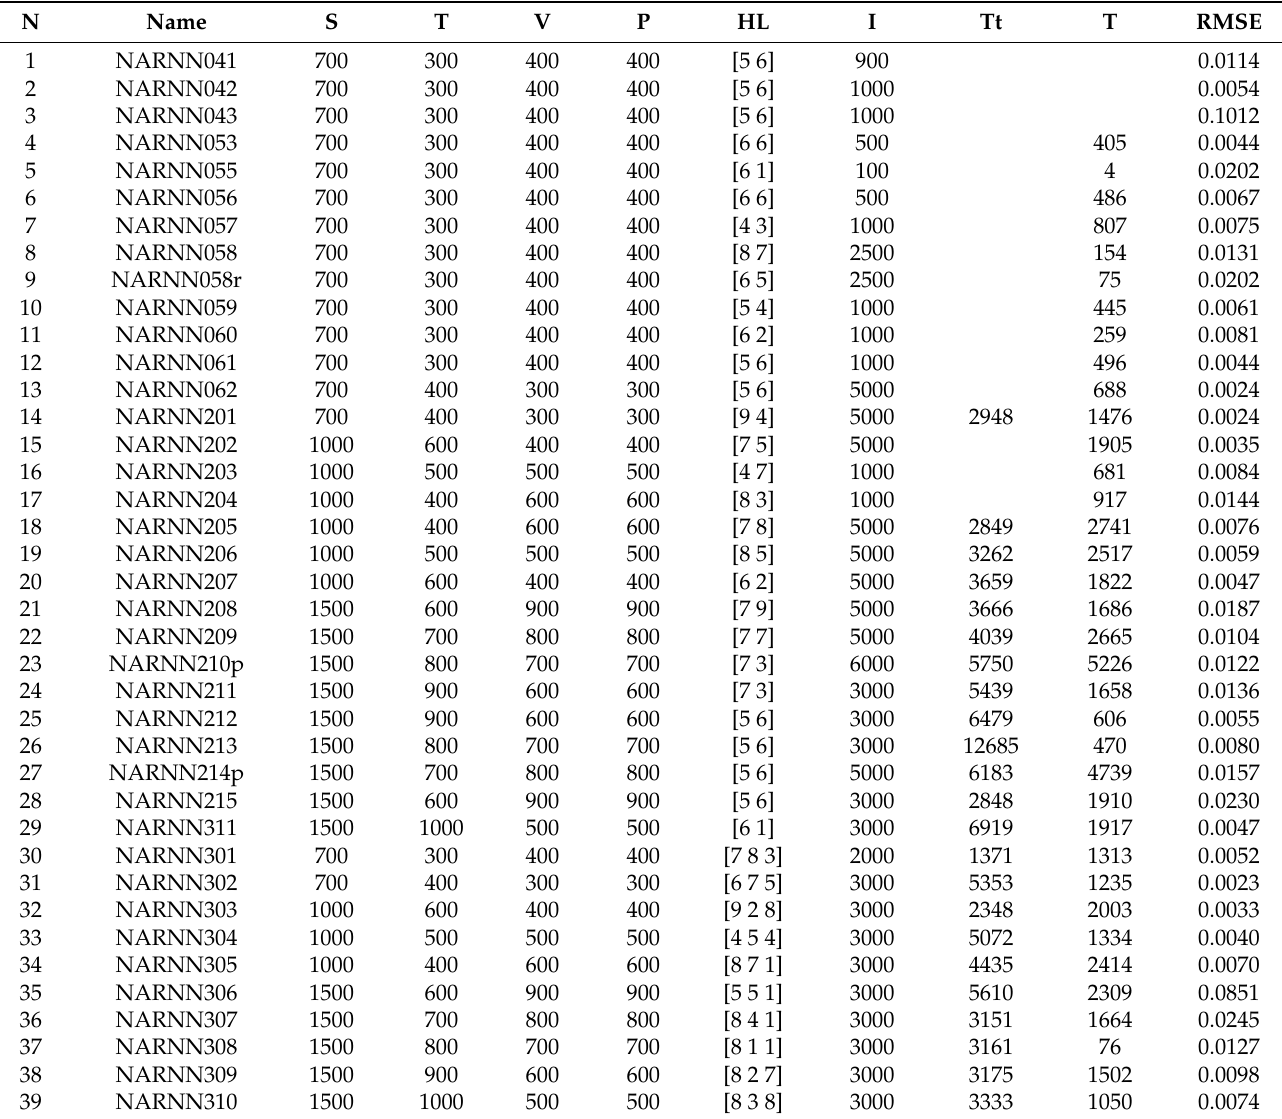
Table 3. Results of optimized